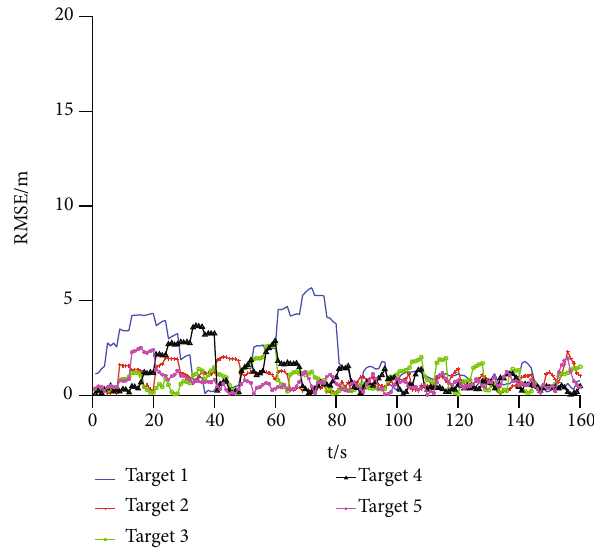
Figure 7: The velocity RMSE versus time scans of fi ve targets.